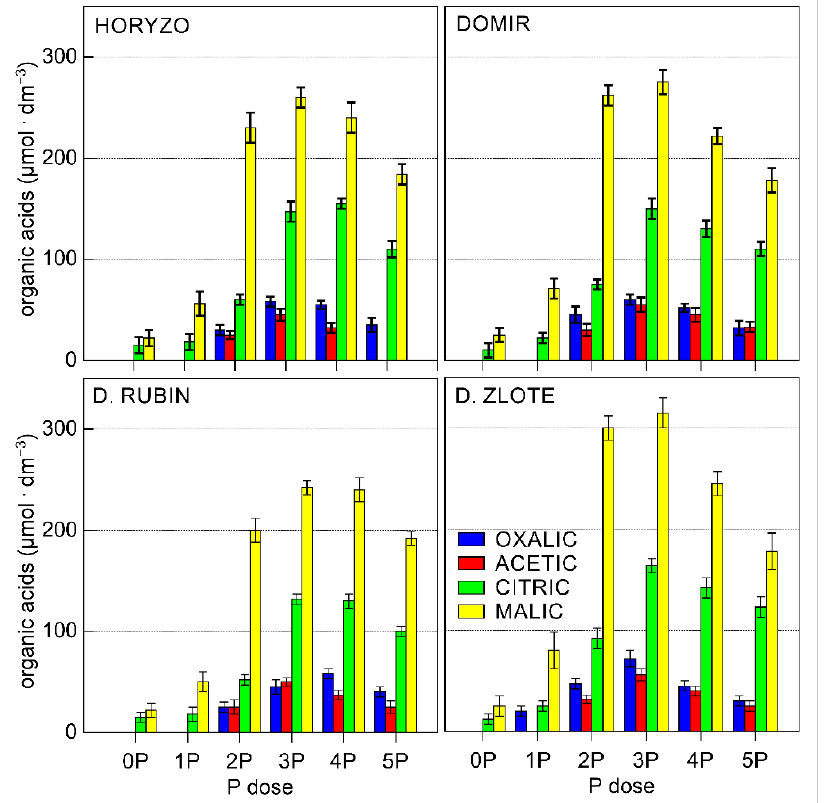
Figure 3. Effect of variable P supplementation on the organic acid (OA) exudation in roots of rye varieties grown on the post-flotation sediment. Soil solutions were collected directly from the root zone of intact plants with lysimeter microprobes, filter-sterilised, and analysed by UHPLC. Data represent the means of n = 9 replications, and vertical bars represent 95% confidence interval after a post hoc Tukey HSD test (interaction P dose × variety), with the letters denoting homogeneous groups being omitted for a clear view.